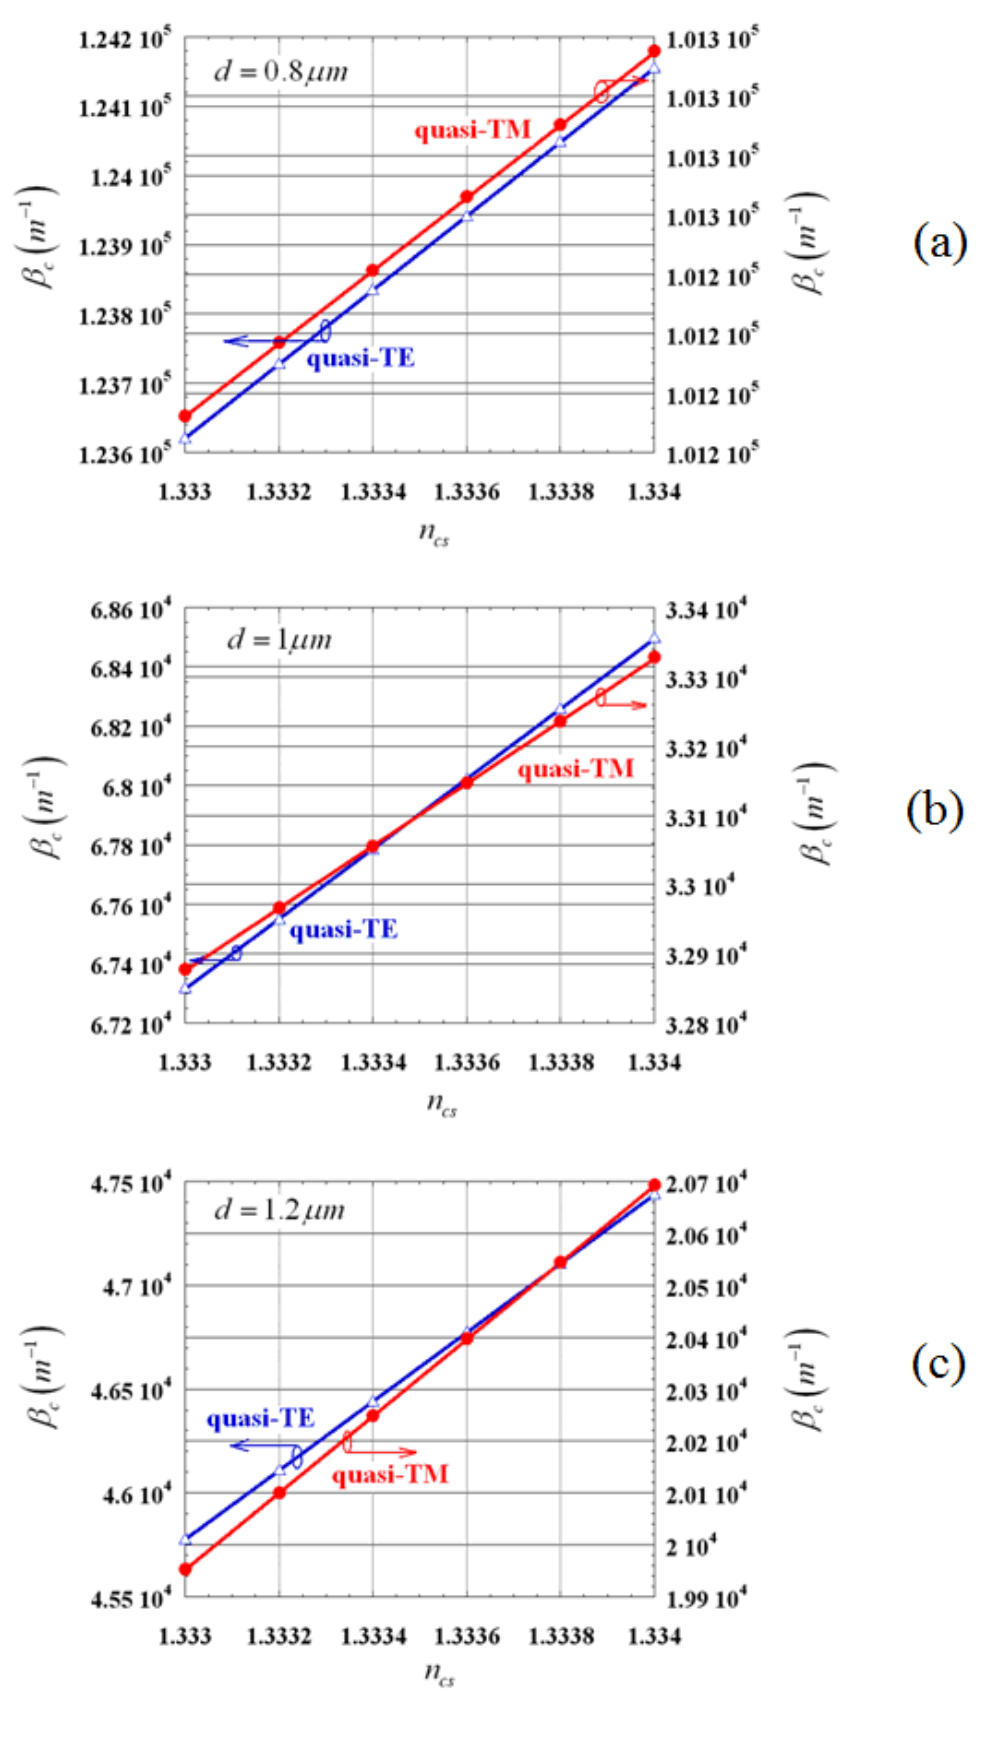
on n : a) d = 0.8 μ m; b) d = 1 μ m; c) d = 1.2 μ c cs